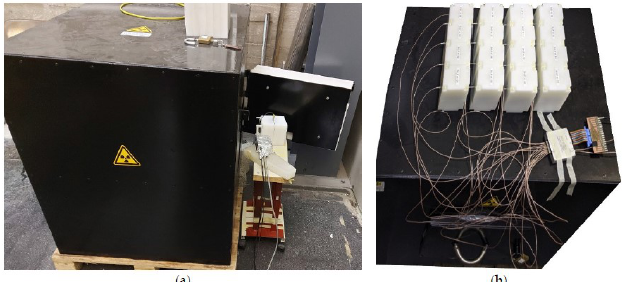
Fig. 4. (a) The AmBe neutron source box with a SiLiF detector in the front position. (b) The 4 × 4 array of SiLiF detectors in the top